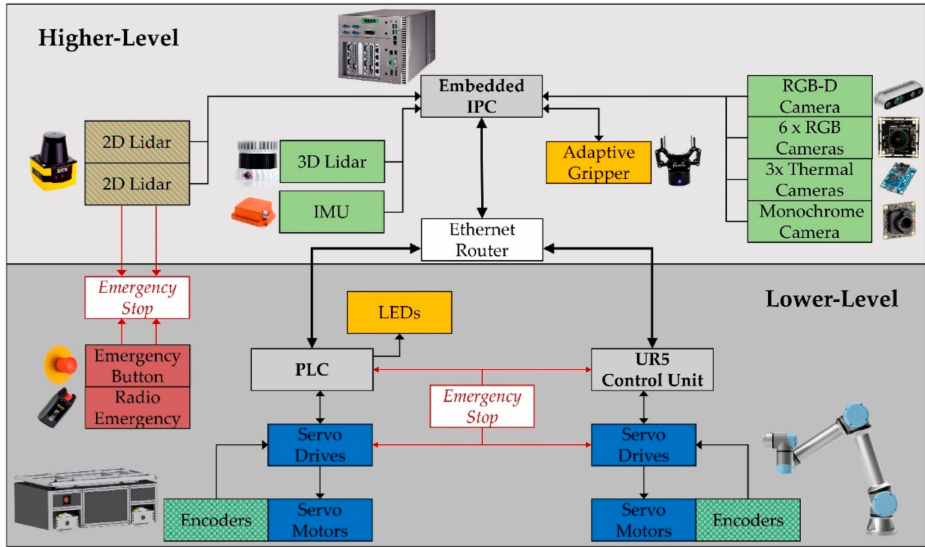
Figure 4. Components and connections of the control system: sensors ( green ), actuators ( blue ), controllers ( gray ), emergency ( red ), and additional peripheral devices ( orange